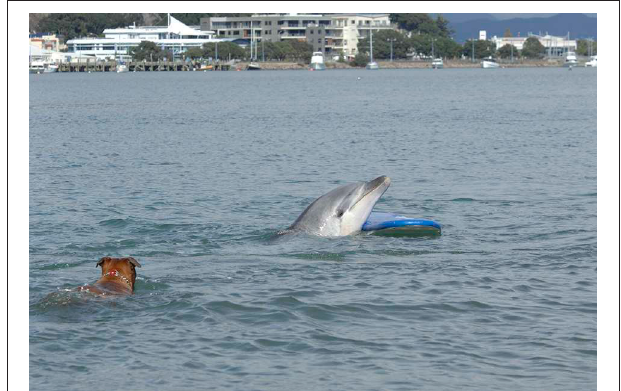
FIGURE 5 | “Moko” with a surfboard he had “stolen” and a dog swimming after him (Photo: Ingrid Visser).